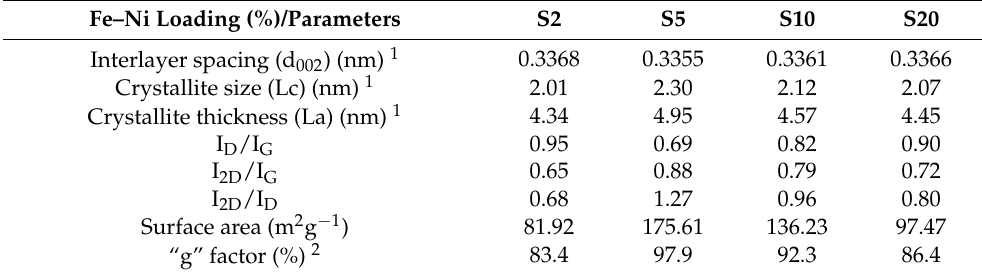
Table 1. Structural properties for the different percentages of the double catalyst